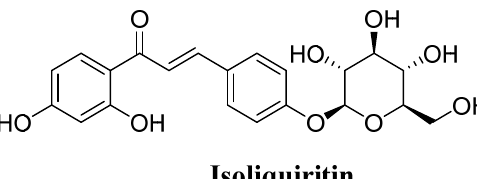
Figure 33. Liquiritin.